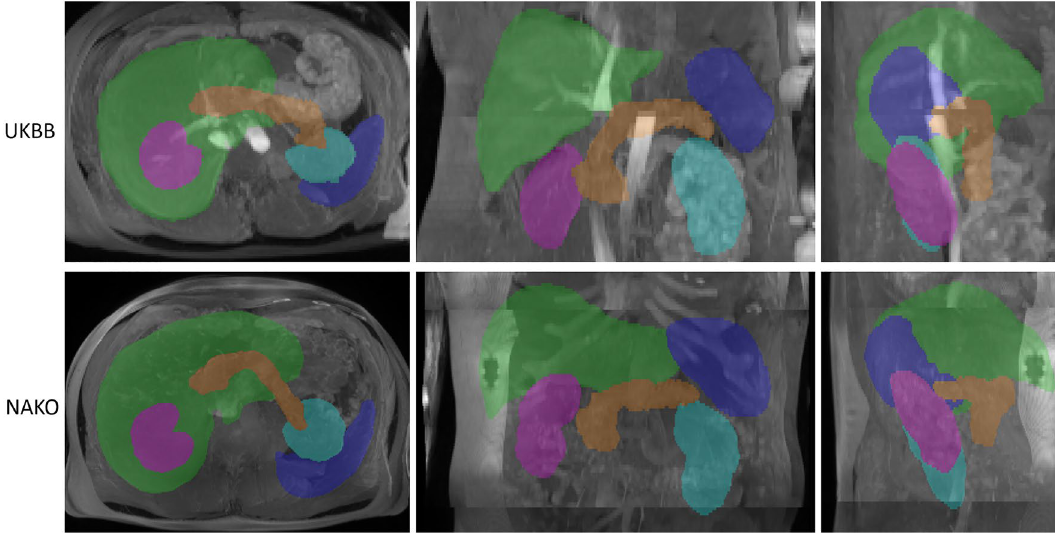
Figure 5. Axial (left), coronal (middle) and sagittal (right) maximum intensity projections of error-free automated segmentation results (green = liver, blue = spleen, turquoise = left kidney, pink = right kidney, orange = pancreas) of UKBB (top) and NAKO (bottom).